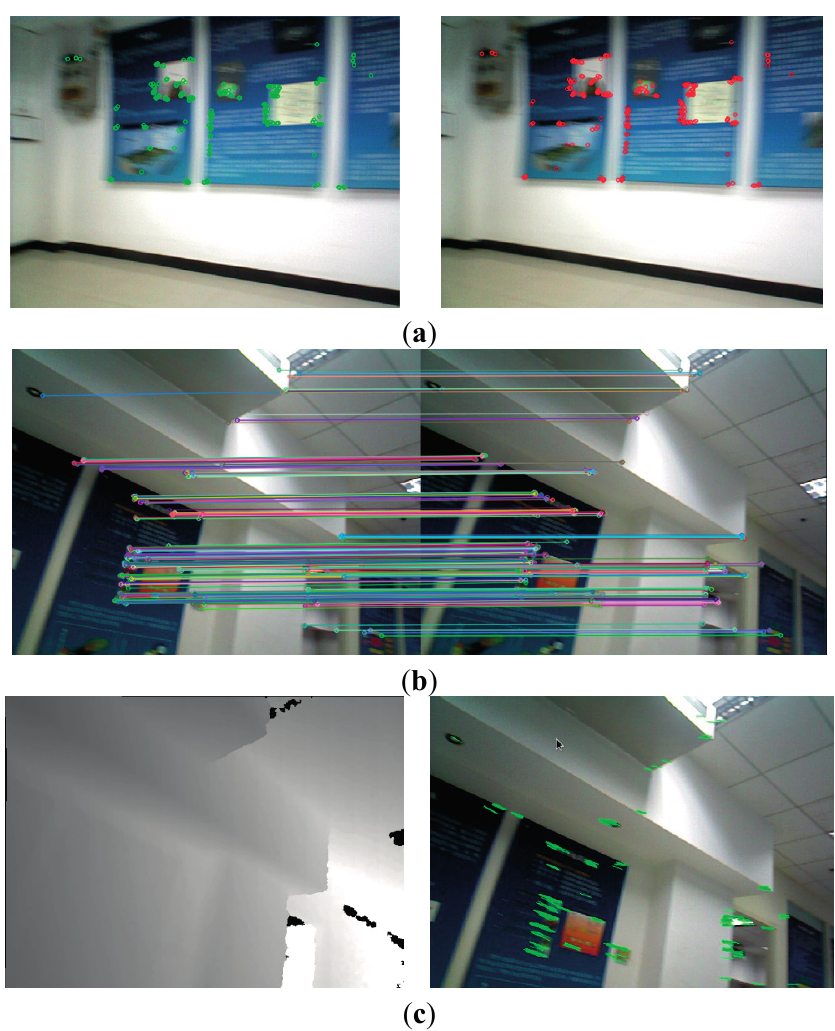
Figure 8. Experimental results of feature detection and matching. ( a ) Features extracted from images captured at time step m − 1 ( left ) and m ( right ); ( b ) feature correspondences; ( c ) depth image captured by the RGB-D camera ( left ) and optical-flow between consecutive images ( right